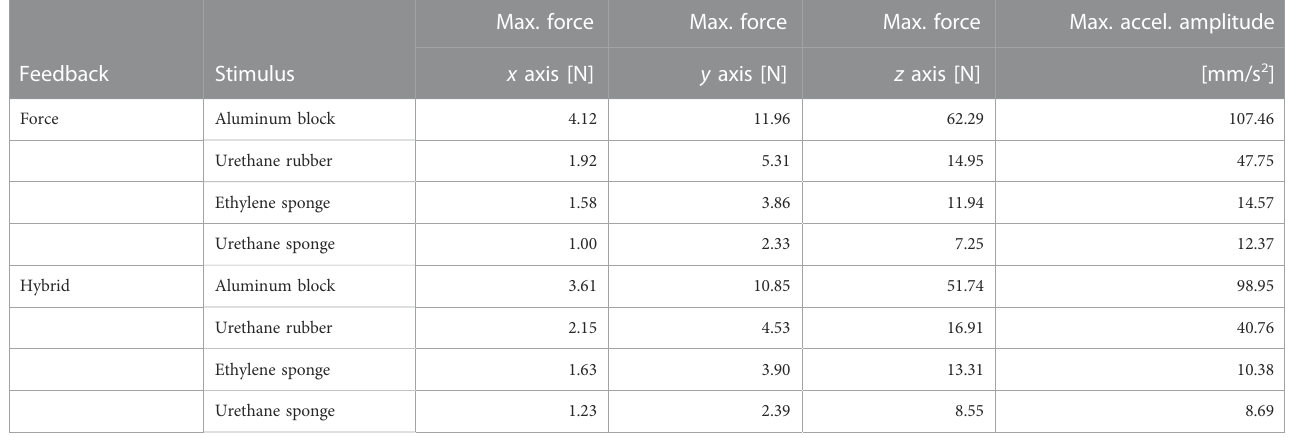
TABLE 1 Mean force and acceleration values during hardness discrimination using push touch mode.